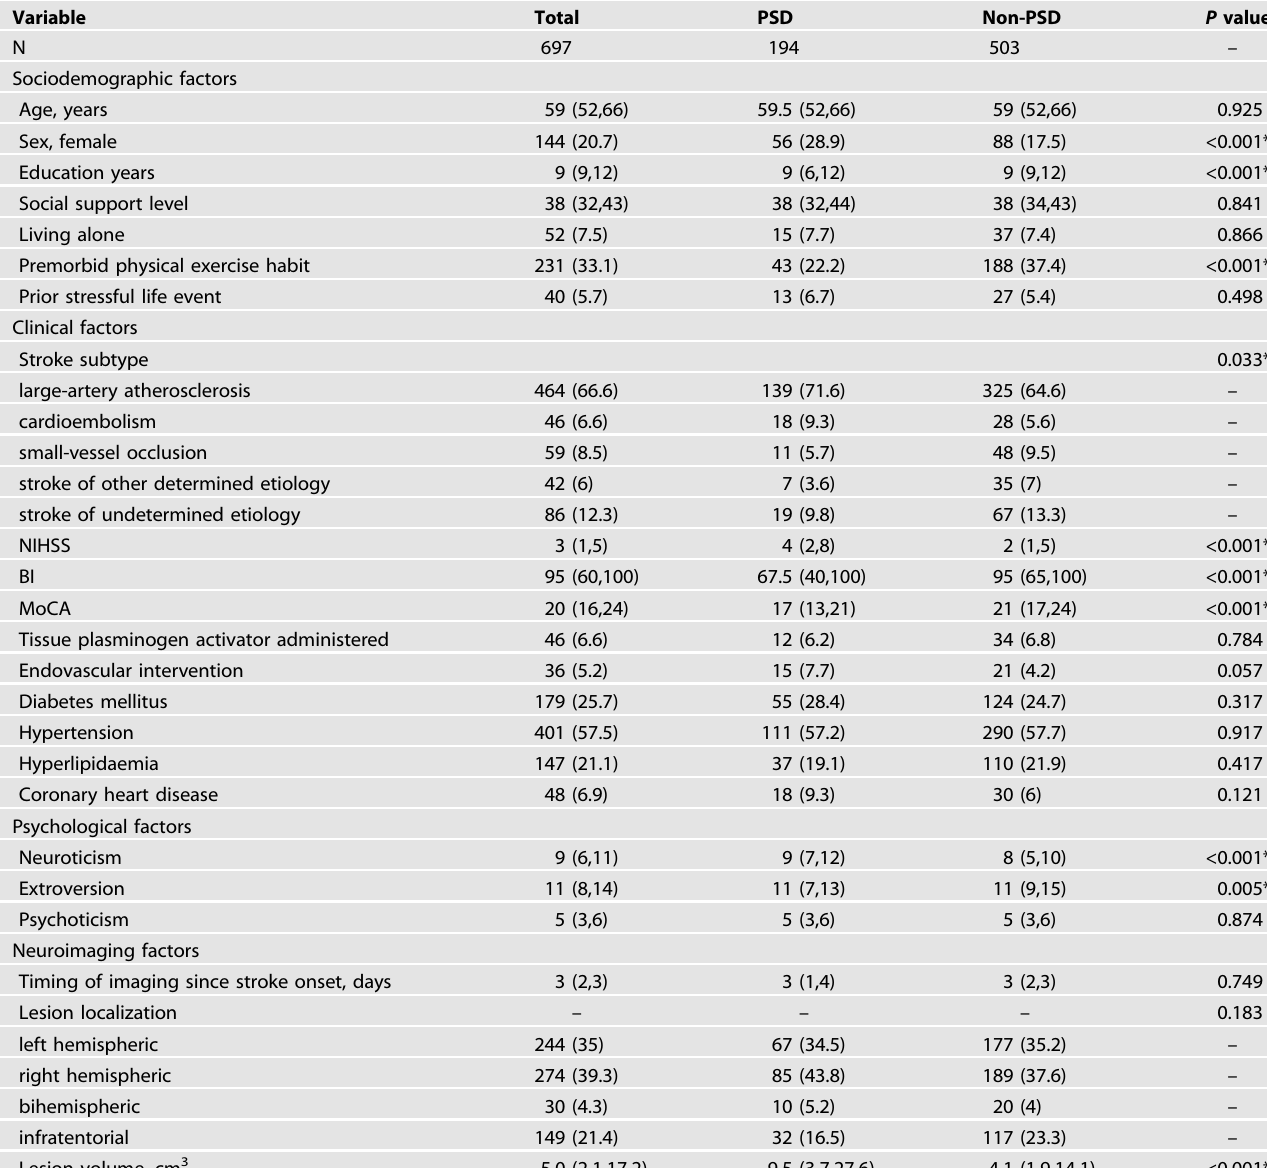
Table 1. Baseline characteristics of the study